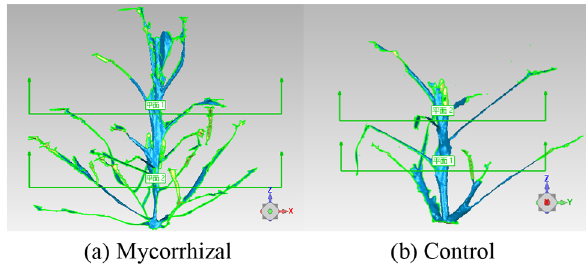
Figure 4. Stratification of stem structure in the peanut